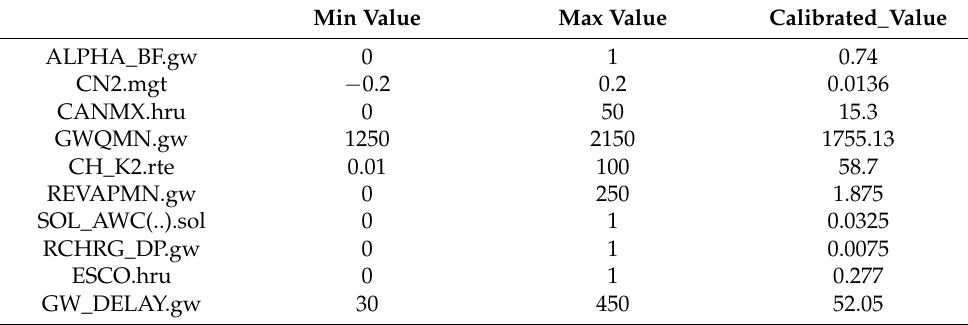
Table 9. Final calibration parameters and their fitted values for the SWAT model.